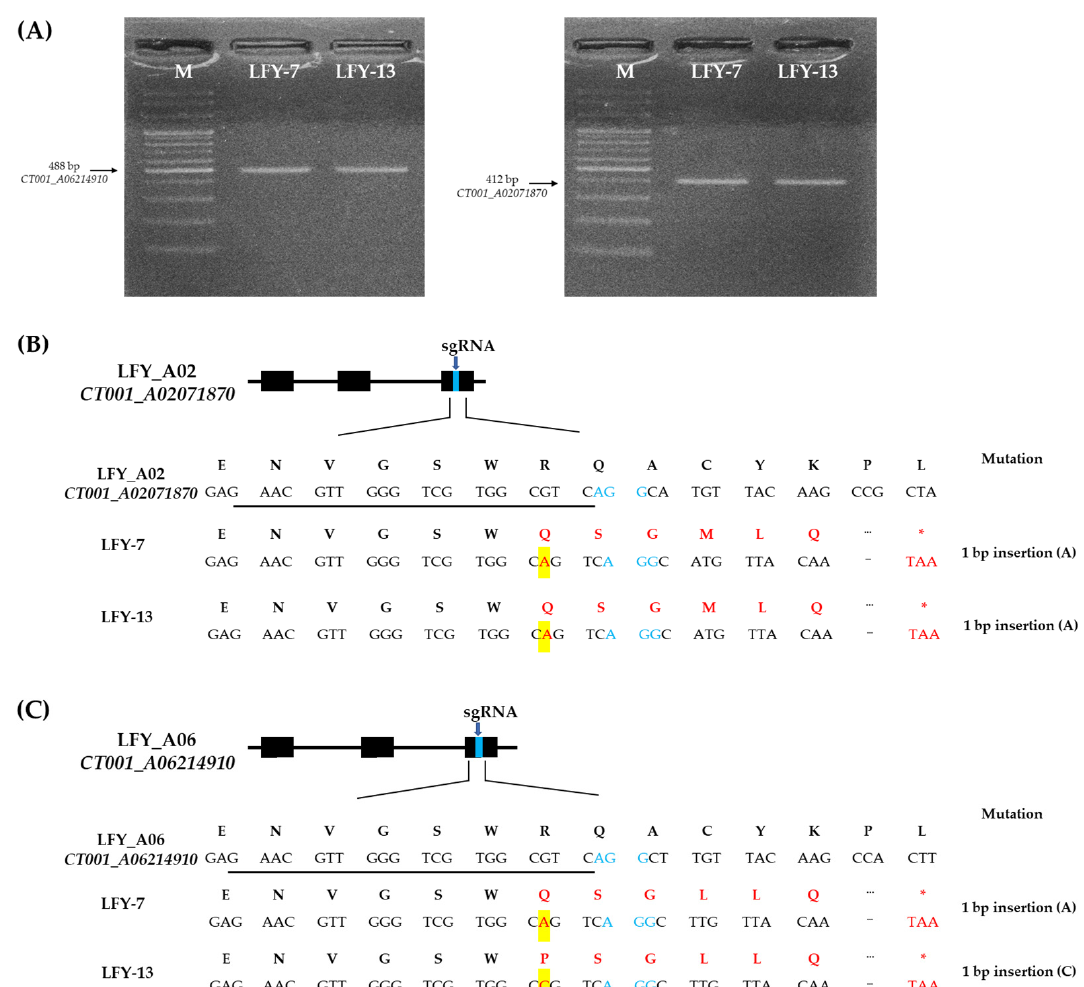
Figure 3. Sequence-based detection of mutations induced by CRISPR/Cas9 system in the BrLFY paralogs of the E 0 LFY -edited lines. ( A ) PCR analysis results based on the target gene-specific amplifying primer sets of the E 0 LFY -edited lines. M, 100 bp DNA ladder; Numbering lane, LFY - edited lines. ( B ) Mutagenesis of CT001_A02071870 at the genomic DNA and amino acid levels in the LFY-7 and LFY-13 edited lines. ( C ) Mutagenesis of CT001_A06214910 at the genomic DNA and amino acid levels in the LFY-7 and LFY-13 edited lines. sgRNA sequence is underlined in black and PAM sequence is shown in blue font. Nucleotide and amino acid mutations are indicated by a red font and base insertions are highlighted in yellow boxes. Termination codon is indicated in red asterisk.